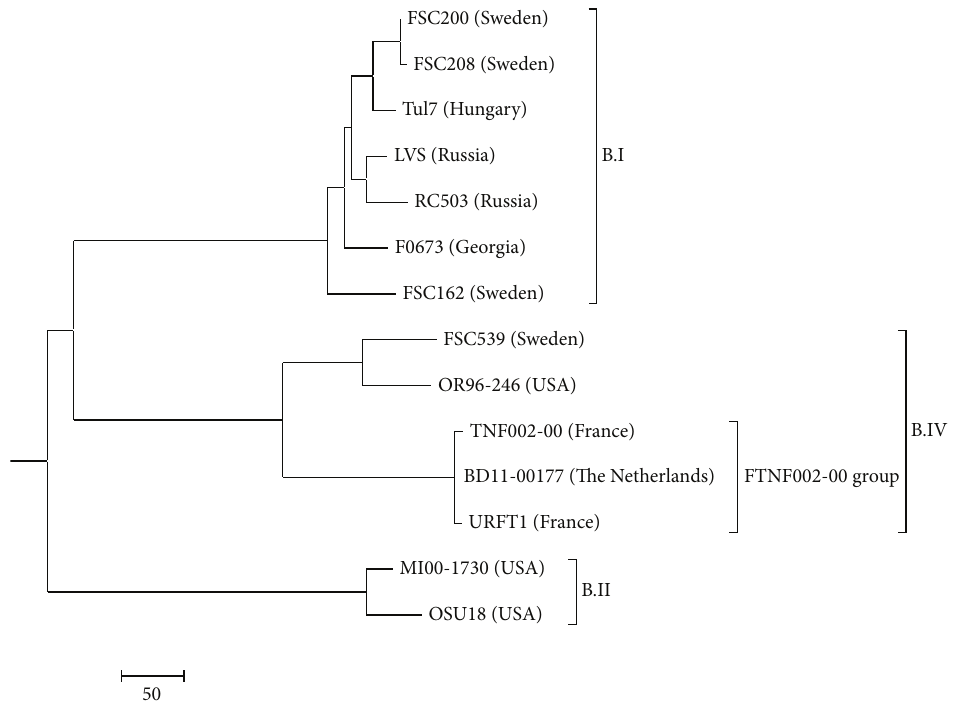
Figure 1: Evolutionary relationships of Francisella tularensis subspecies holarctica strain BD11-00177. The new isolate, BD11-00177, from The Netherlands belongs to the FTNF002-00 genomic